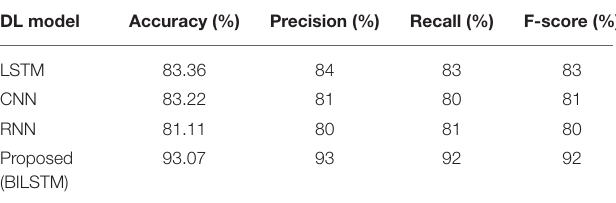
TABLE 6 | BILSTM vs. other DL models.